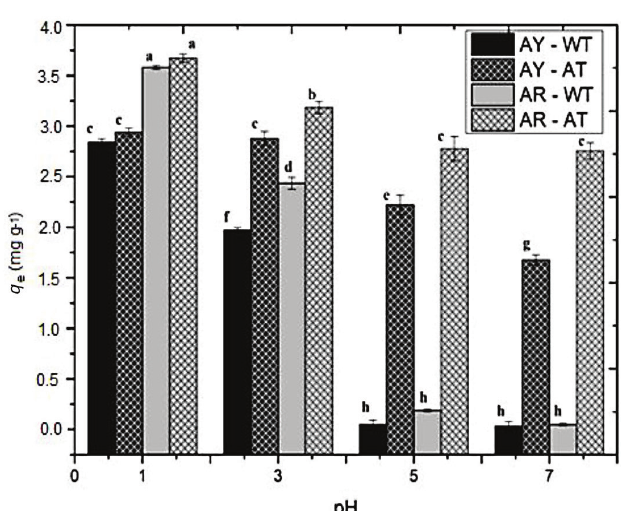
Fig. 4 – Biosorption capacity of textile dyes in Açaí seeds pow- der (with and without acid treatment) for different pH solutions NOTE: q : Biosorption capacity; AY: Acid yellow dye; AR: Acid e red dye; WT: Without treatment; AT: Acid treatment. Means with the same letter do not differ by Tukey test